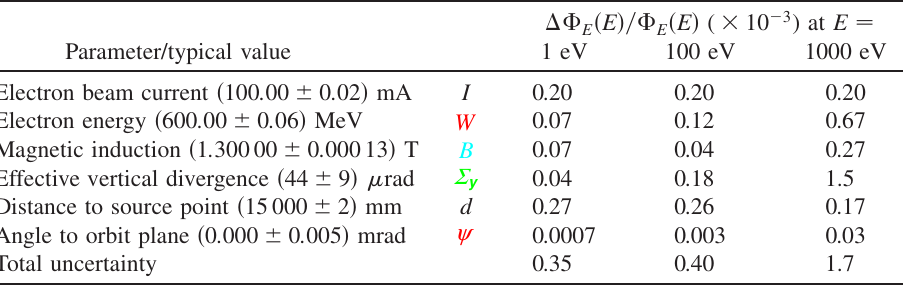
TABLE II. Parameters that enter the calculation with typical values and uncertainties and their influence on the relative uncertainty in the calculation of the radiant power for different photon